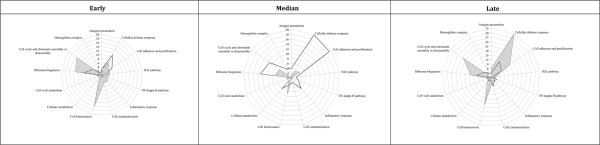
Qualitative and quantitative representations of biological processes (GO) over represented during challenges. Qualitative and quantitative representations of over expressed GO categories (Chi-square with Yates correction p < 0.05). The corners of the spider-web maps represent biological processes identified in the GO analysis. Different numbers of transcripts were grouped in each biological process. The continuous mark lines (black or grey) represent the different number of transcripts in each biological process. The differences in the shape of the GO pattern (continuous mark line) are due to divergence in the number of transcripts grouped to each Gene Class (biological process) under both PGN challenges; the black line shows the GO pattern for PGN-O111:B4 and the grey line shows the GO pattern for PGN-K12 treatment.